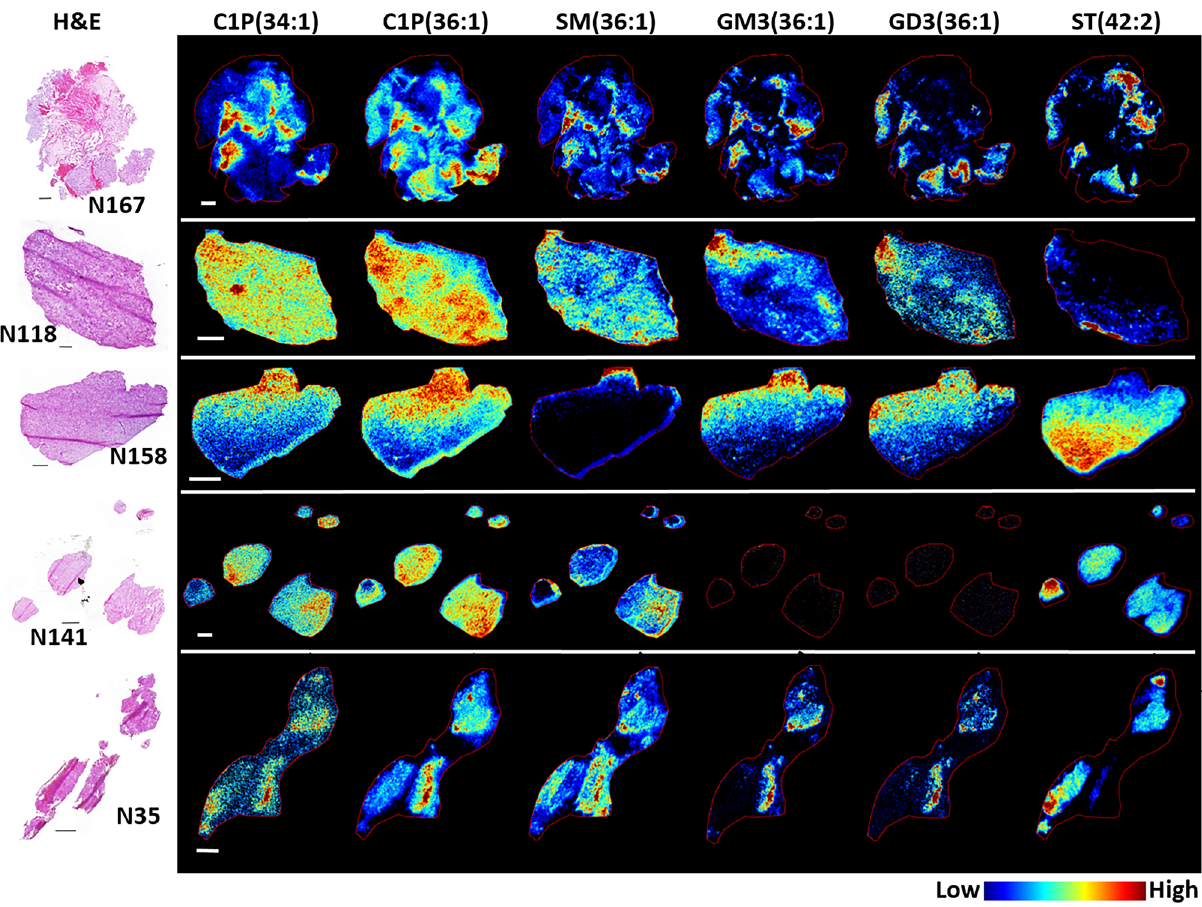
Figure 4. Representative MS images for several sphingolipid species. Sphingolipid subclasses include ceramide- 1-phosphate (C1P), sphingomyelin (SM), mono- and di-sialodihexosylganglioside (GM3 and GD3 respectively) and sufatide (ST). C1P(34:1) and (36:1) correspond to m/z 616.471 and 644.502, respectively. SM(36:1) corresponds to m/z 715.578. GM3(36:1) and GD3(36:1) correspond to m/z 1179.741 and 1470.830, respectively. ST (42:2) corresponds to m/z 888.624. Images were acquired at 30 µm pixel resolution from 5 µm thick sections; the H&E stained section of each sample is shown in the left panel. Scale bars are 1 lipid was also highly localized to regions containing actively migrating cell populations, histologically character- ized as pseudopalisading tumor cells 30 . Understanding the functional relevance of PI(38:3) in these migrating glioblastoma cell populations is an important next step of research. Additionally, the PTEN/PI3K/AKT/mTOR pathway has been extensively studied in glioblastoma and a number of pathway inhibitors are in preclinical and clinical trials 45 . Targeting the downstream PIs that feed into this pathway may offer a novel therapeutic approach. Sphingolipids. Sphingolipids are a diverse family of lipids involved in numerous cell signaling processes that regulate cell division, differentiation, migration and apoptosis. Over 40 different sphingolipids were detected, encompassing the subclasses of ceramide-1-phosphates (C1P), sphingomyelin (SM), sulfatides (ST) and gangli- osides. A full list of the sphingolipids detected along with their structure-based histology-specific accumulation within each sample are presented in Supplementary Tables S3, S4, S5, S6 Representative images demonstrat- ing the structure-based heterogeneous distribution for each subclass is shown in Fig. 4. With the exception of sulfatide, sphingolipids were predominantly localized to regions of necrosis (N167), acellular fluid filled regions (N35), and areas of MVPs (N167, N118 and N35). Few C1Ps and gangliosides were detected within the tumor cell regions and those that were shared similar carbon chain lengths and levels of saturation in their fatty acid structures, irrespective of their sub-class. This can be observed by comparing the spatial distribution of C1P(36:1), GM3(36:1) and GD3(36:1) to one another. All of these lipids were accumulated within the same regions of moderate-to-high tumor cell density in samples N167 and N158. C1P(36:1) was also highly accu- mulated in regions of MVP surrounding necrosis in samples N167 and the MVP formations of microvascular sprouting and vascular clusters in sample N118. Interestingly, in sample N118, C1P(34:1) was more highly accu- mulated in the vascular garland structure when compared to C1P(36:1). C1Ps are part of the sphingolipid rheostat that determines cell fate, in which ceramide promotes cell growth arrest and death through multiple signaling pathways, whereas metabolism of Cer to sphingosine-1-phosphate